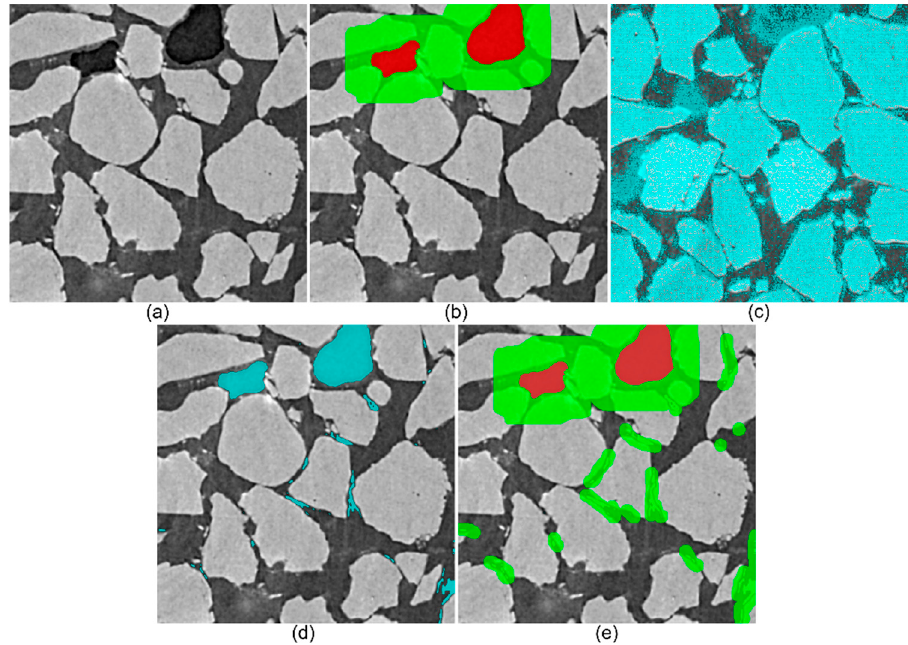
Figure 5. RootPainter usage example (on IC01 data): ( a ) XY slice from 2D learning subvolume; ( b ) slice annotations used from training and validation with CH 4 (foreground) shown in red and background shown in green; ( c ) initial segmentation output with a large number of erroneously labelled voxels; ( d ) improved segmentation with a small number of erroneously labelled voxels; ( e ) annotative correction of mislabelled voxels.